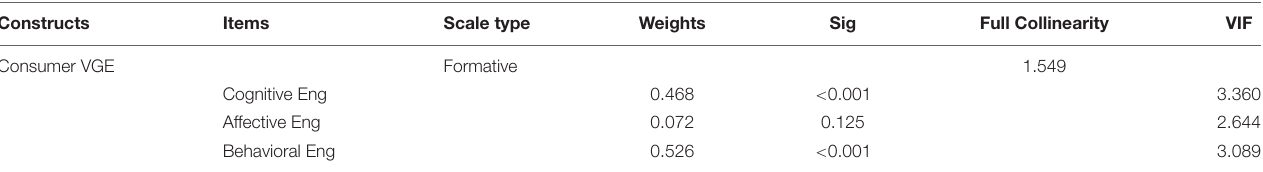
TABLE 5 | Assessment of the measurement model of higher-order formative construct (consumer videogame engagement).